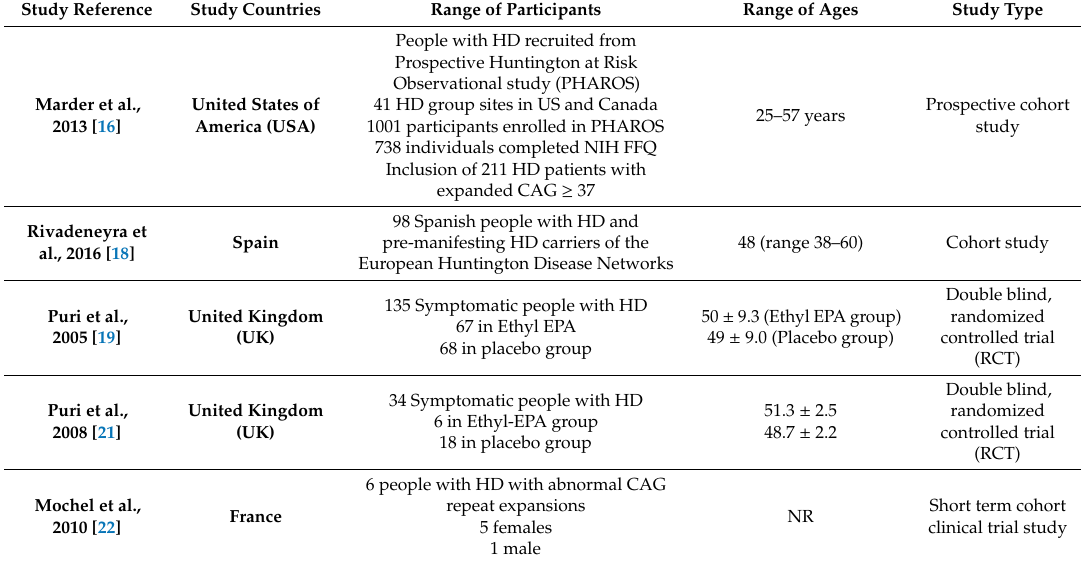
Table 1. Overview of studies included in the